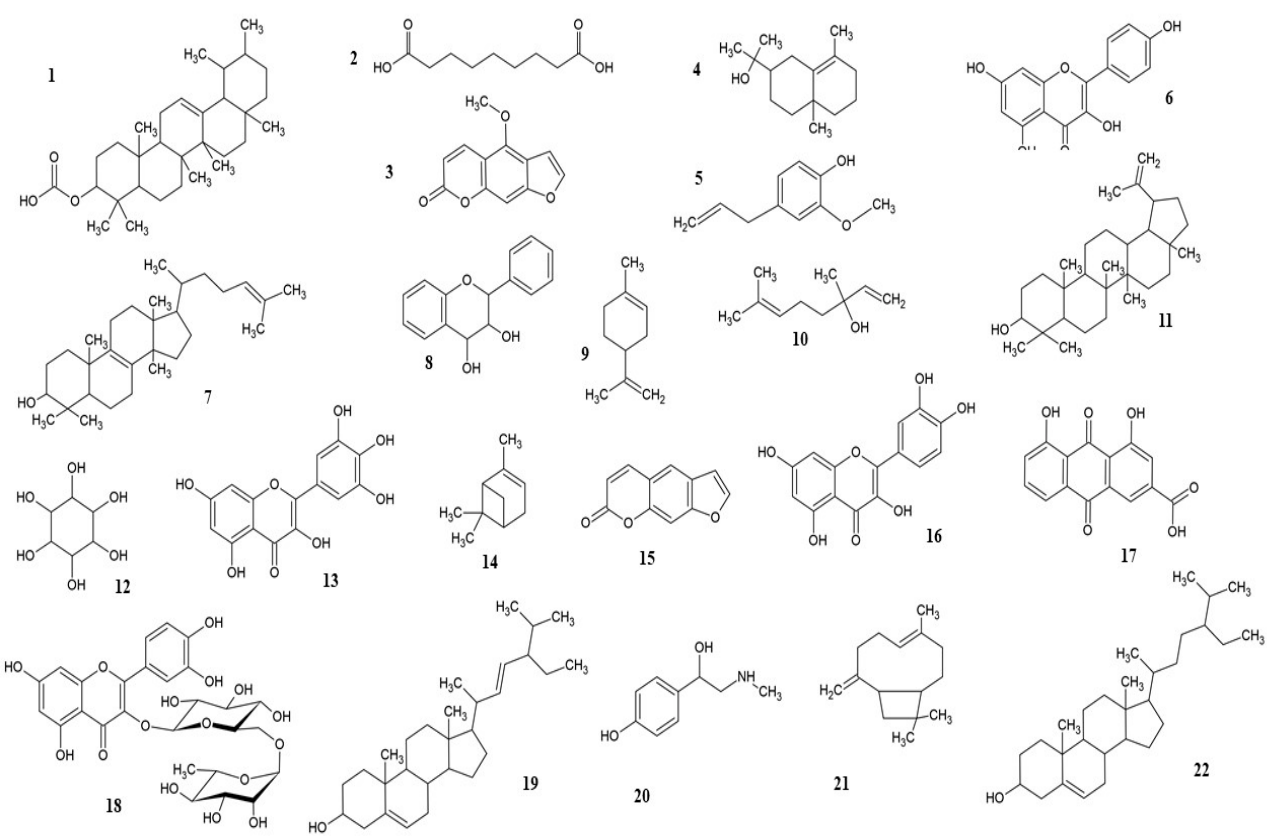
Figure 1. Some important phytocompounds from F. religiosa and F. benghalensis : 1 , amyrin; 2 , azelaic acid; 3 , bergapten; 4 , eudesmol; 5 , eugenol; 6 , kaempferol; 7 , lanosterol; 8 , leucoanthocyanins; 9 , limonene; 10 , linalool; 11 , lupeol; 12 , myo-inositol; 13 , myricetin; 14 , pinene; 15 , psoralen; 16 , quercetin; 17 , rhein; 18 , rutin; 19 , stigmasterol; 20 , synephrine; 21 , β -caryophyllene; 22 , β -sitosterol.